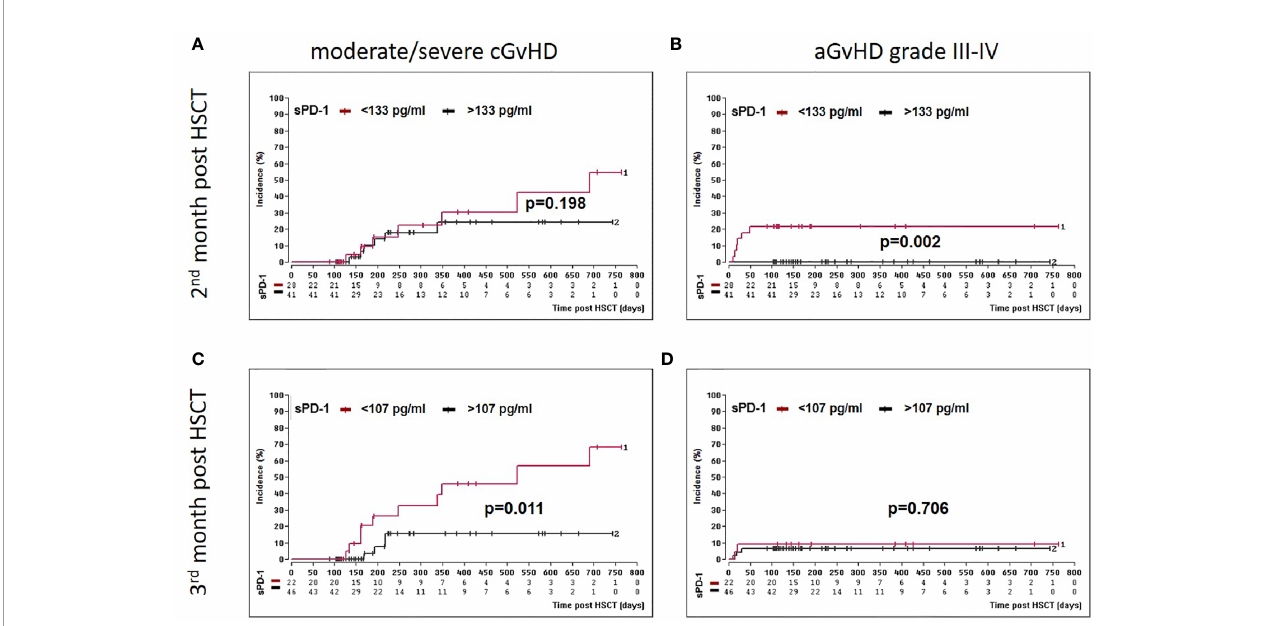
FIGURE 4 | Association of low sPD-1 level with aGvHD grade III-IV and moderate/severe cGvHD. Patients were divided into two groups according to cut-off levels [(< or >133 pg/ml, (A, B) ] or [(> or <107 pg/ml, (C, D) ] obtained two (A, B) and three months (C, D) post HSCT, respectively. Estimated cumulative incidence curves of patients with moderate/severe cGvHD (A, C) and aGvHD grade III-IV (B, D) as competing event are shown for patients with sPD-1 <133 pg/mL (A, B) or <107 pg/ml (C, D) in brown and compared to patients with >133 pg/mL(A, B) and >107 pg/ml (C, D) in black. The sPD-1 levels were available only for 69 patients (A, B) at month two or 68 patients (B, C) at month three post HSCT due to death or loss of follow